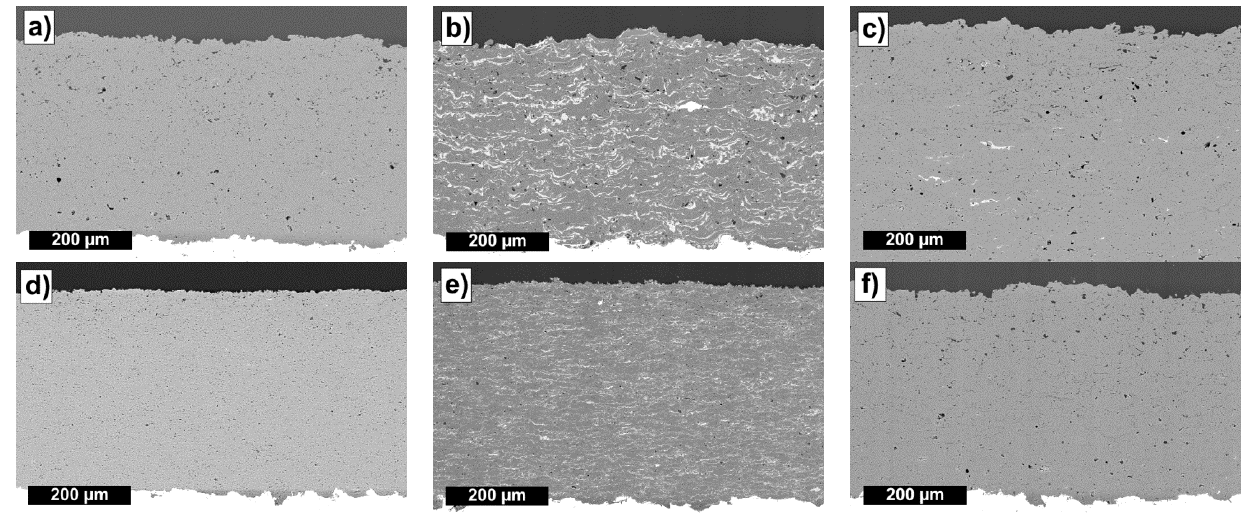
Figure 4. Structure of ( a ) APS_A; ( b ) APS_AT1 (F/C); ( c ) APS_AT2 (A/S); ( d ) HVOF_A; ( e ) HVOF_AT1 (F/C); and ( f ) HVOF_AT2 (A/S) coatings. SEM images.